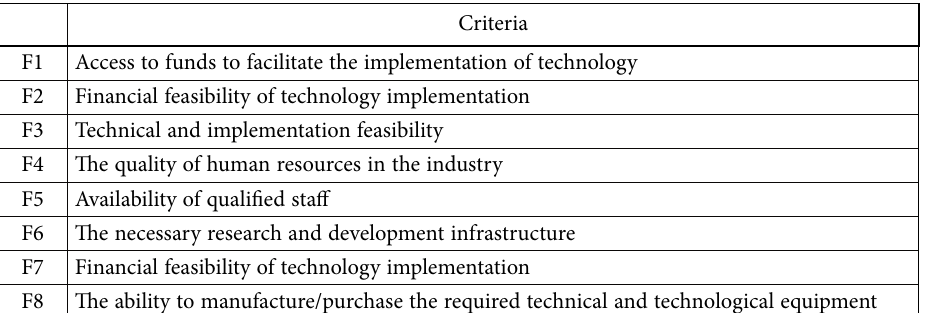
Table 2. Feasibility criteria considered in ‘NT FOR Podlaskie 2020’